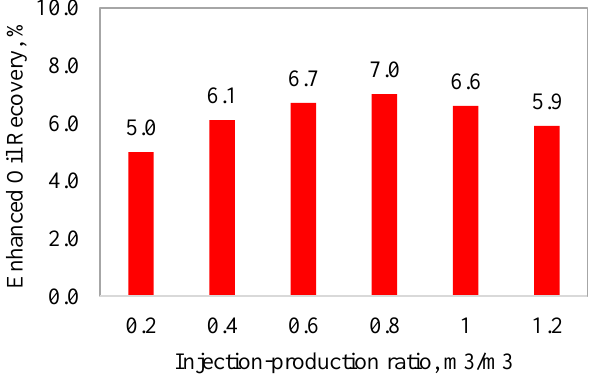
Figure 8—Numerical simulation of the effect of the injection-production ratio on oil